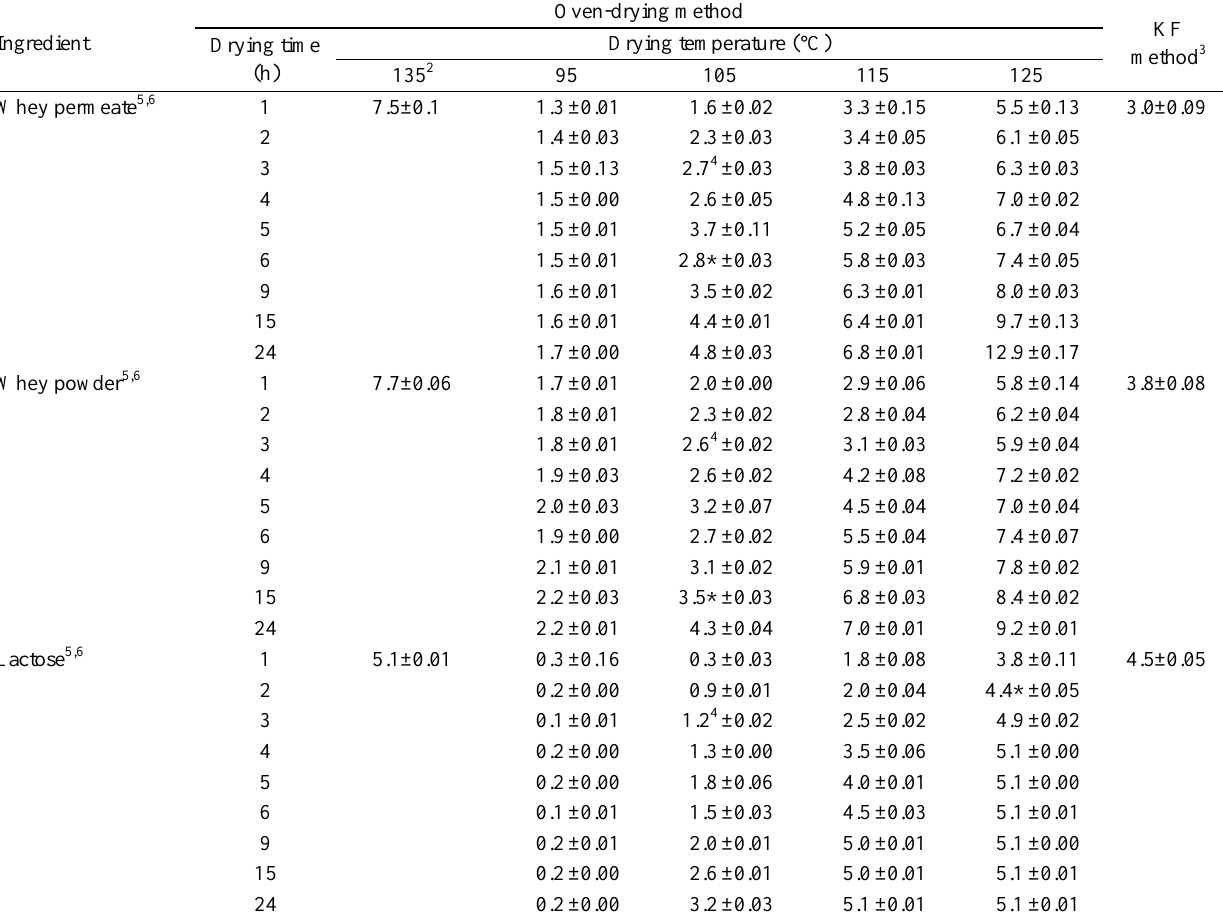
Table 3. Moisture concentrations (%) in whey permeate, whey powder, and lactose determined by various oven methods and the Karl Fischer (KF) method (Exp. 2)